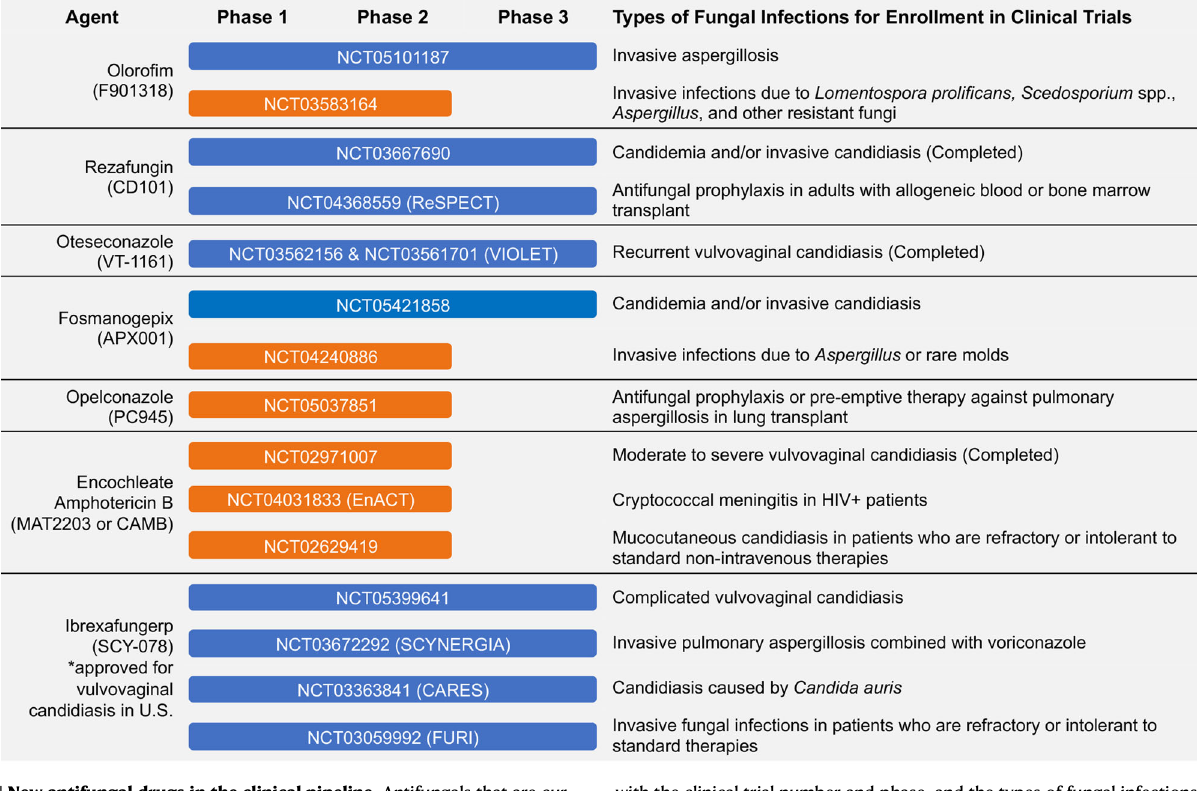
Fig. 3 | New antifungal drugs in the clinical pipeline. Antifungals that are cur- rently in phase 2 or 3 clinical trials for the treatment or prophylaxis of fungal infections. The antifungal names as well as other identi fi ers are provided, along